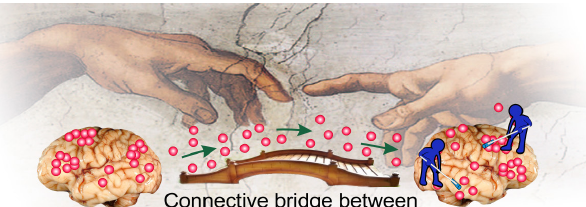
Fig. 6. The schematic illustration of function of meningeal lymphatic system. The molecules crossing the opened BBB eliminate from the BBB via the meningeal lymphatic